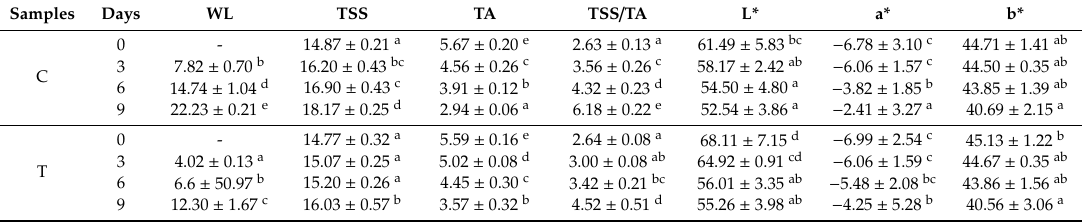
Table 1. Weight loss (WL; %), total soluble solid content (TSS; ◦ Brix), titratable acidity (TA; g of